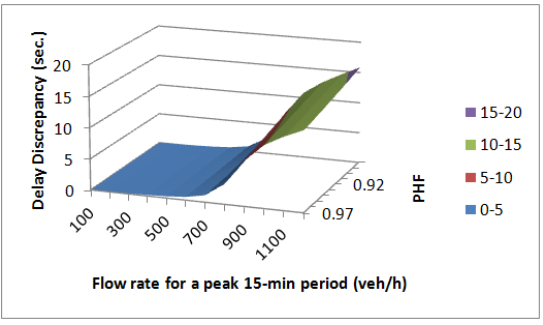
Figure 9. Impact of 2% Reduction in PHF on Control Delay